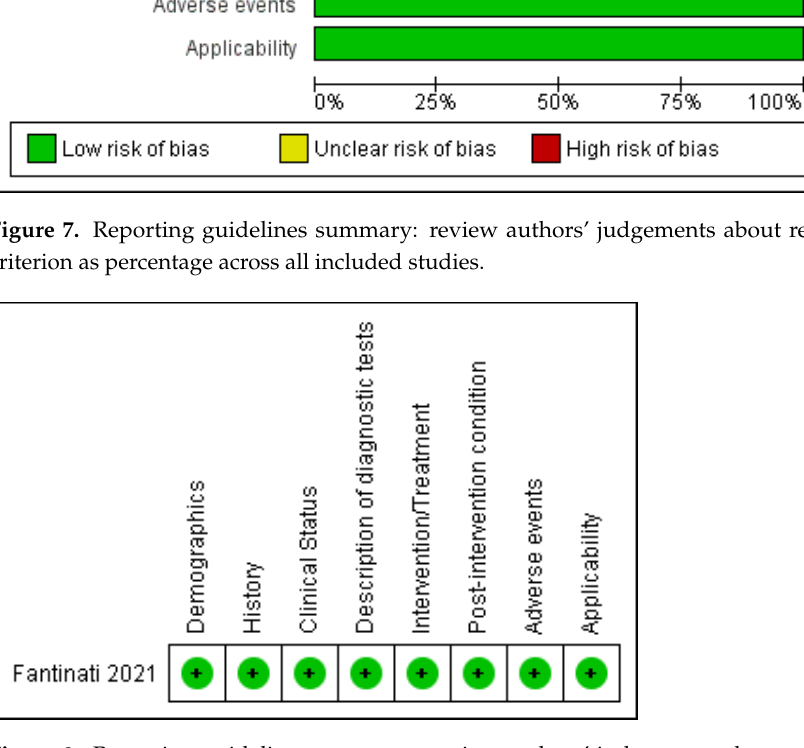
Figure 8. Reporting guidelines summary: review authors’ judgements about reporting on each criterion for each included